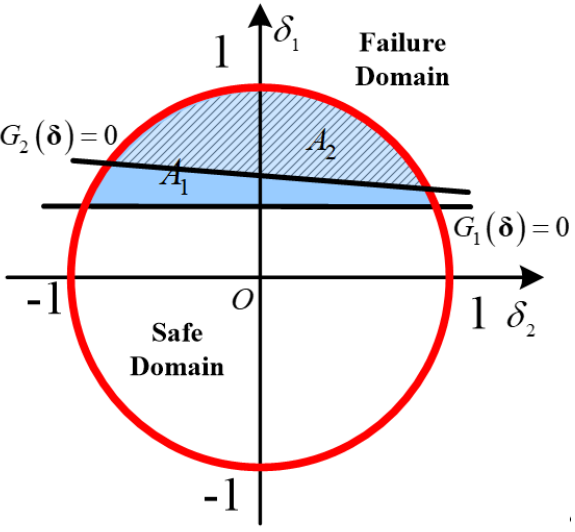
Figure 2. Redundant failure mode in the system.